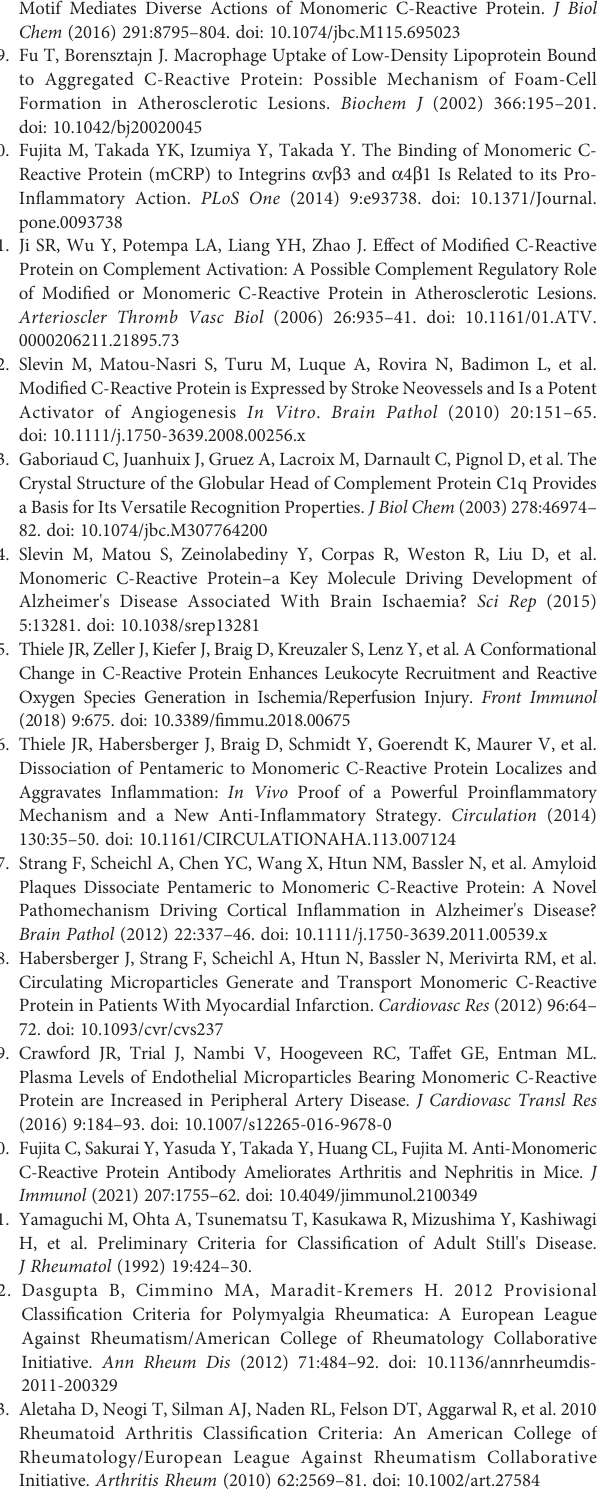
was determined as approximately 0.63 to 40 ng/ml. (B) Dilution linearity of plasma samples was certi fi ed ( R 2 = 1; 5 to 50